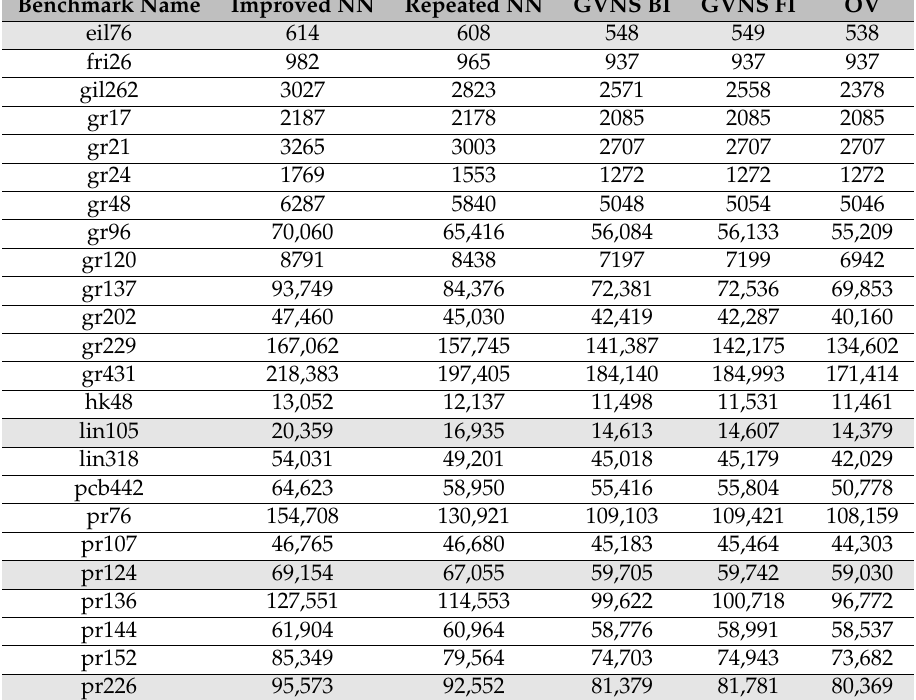
Table 3. The experimental results show that GVNS outperforms the improved and the repeated NN on TSP instances